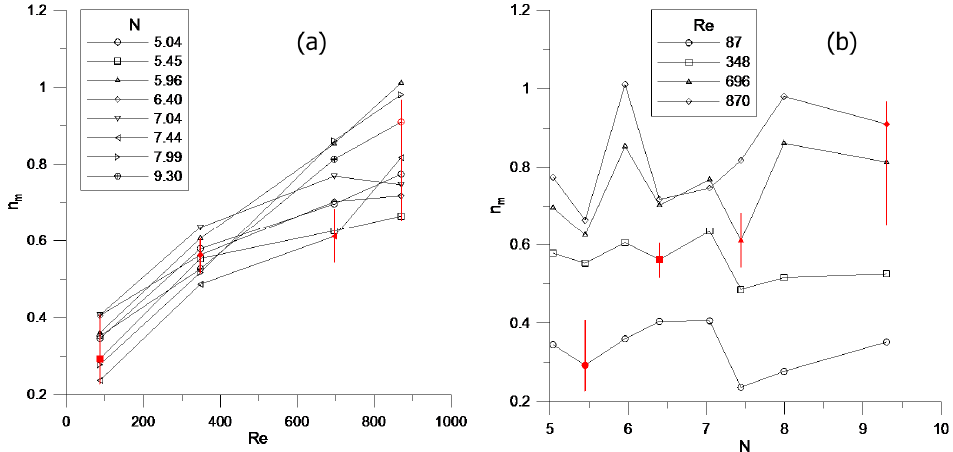
Figure 15. Variation of parameter n m against ( a ) Re for all values of N ; and ( b ) N for all values of Re.